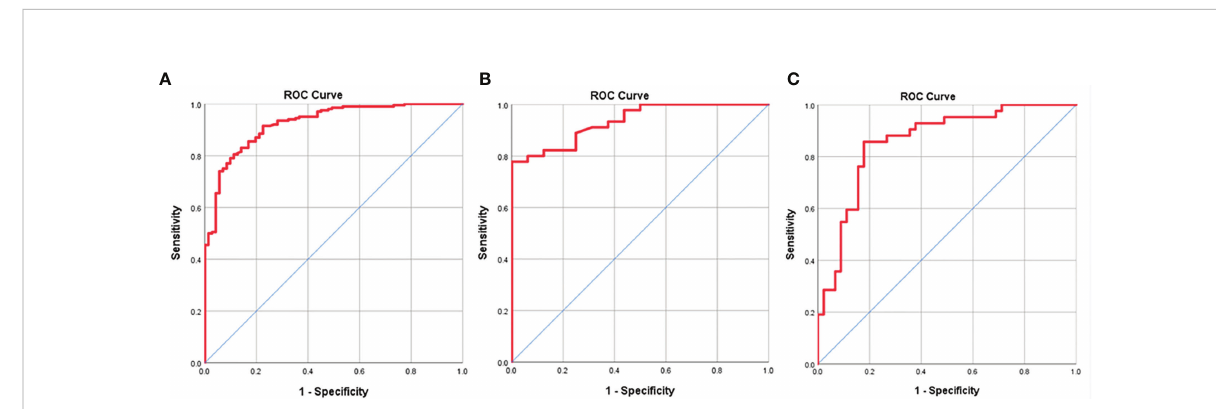
FIGURE 2 Receiver operating characteristic (ROC) analysis of N-stage based gross tumor volume (GTV) has been performed for estimating the resectability of gastric adenocarcinoma, and the ROC curves show that GTV can help judge the resectability of the tumor in stages cN 0-3 (A) , cN 2 (B) and cN 3 (C) with the cutoff values of 21.83, 21.70 and 36.93 cm 3 ,